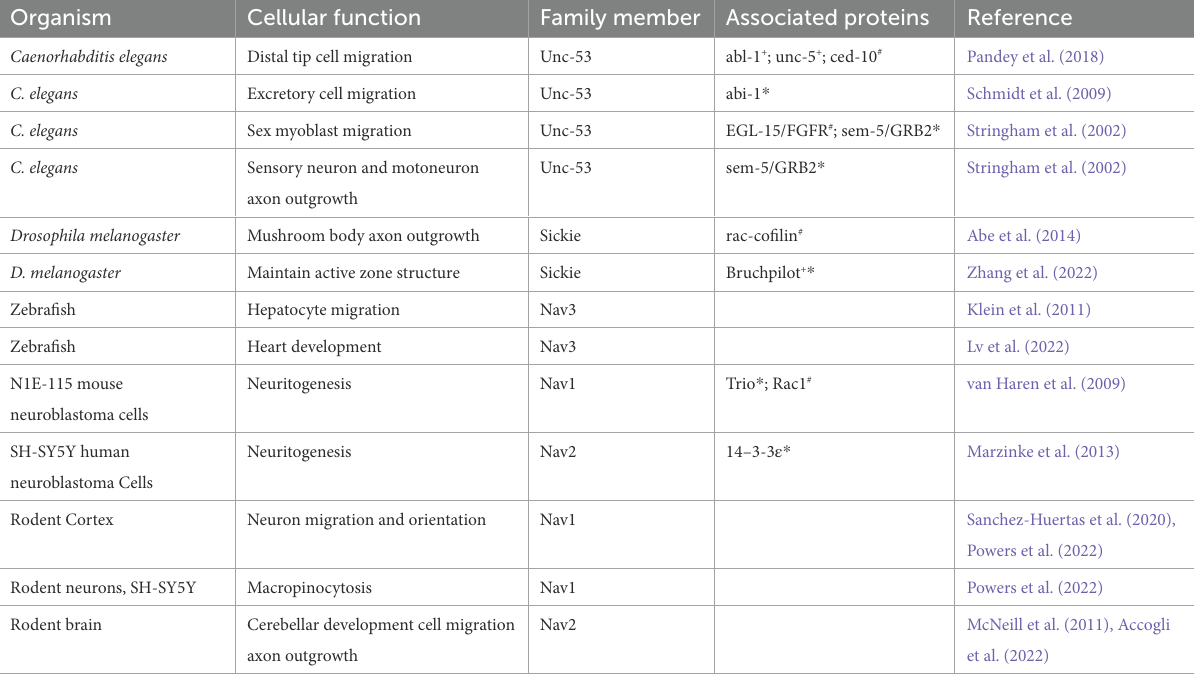
TABLE 1 Proposed cellular function of the navigators based on studies in different organisms.